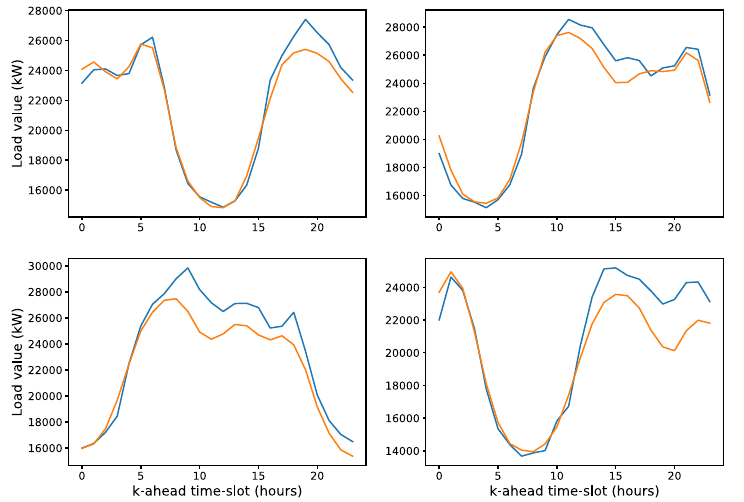
Figure 13. Comparison between real 24 h load signals (blue lines) and their forecasts (orange lines) for data in the test set (model: ensemble Type II ([1 LSTM + 2 FC]*2 + (4 FC)*2) ( 𝑓 = 1, 𝑝 = 168, 𝑘 = 24)).